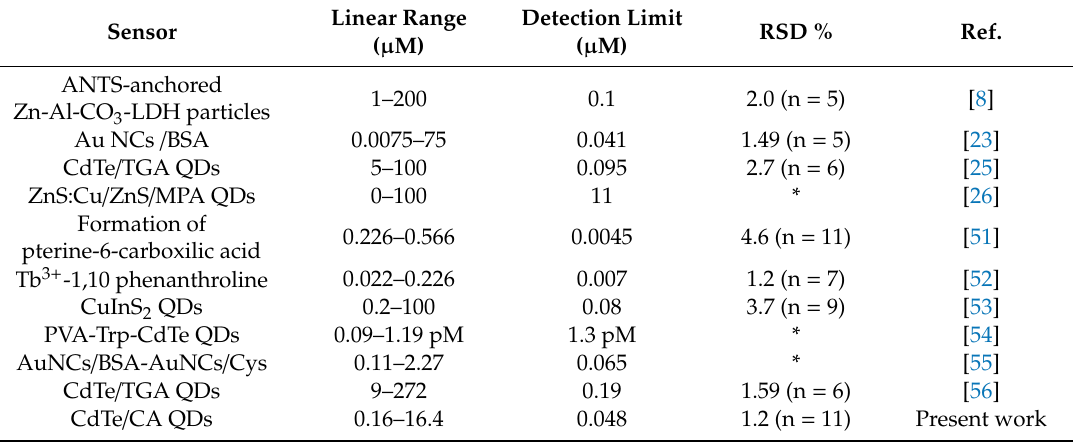
Table 1. Comparison of different fluorescence methods for FA determination.